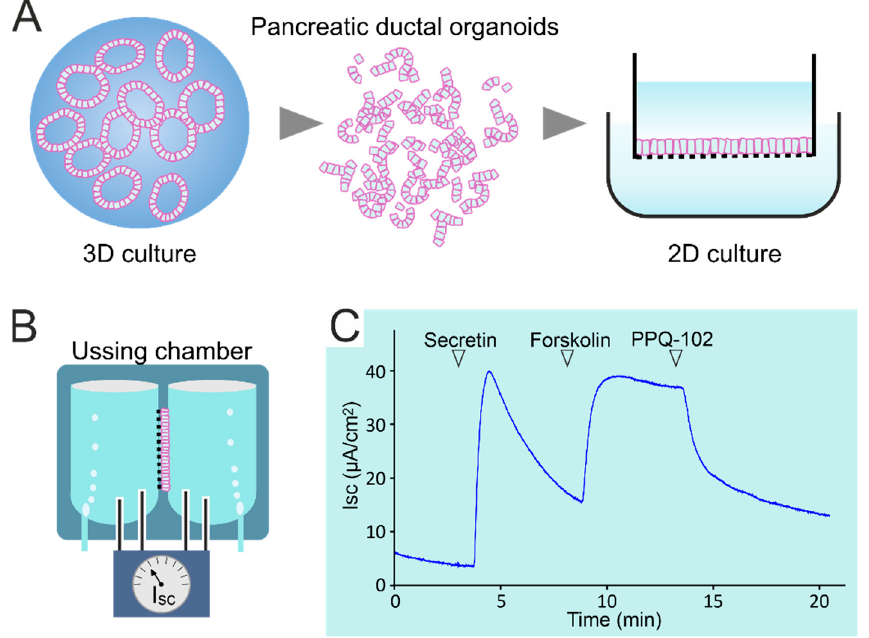
Figure 3. ( A ) Pancreatic ducts were isolated from a porcine pancreas by enzyme treatment and suspended in an extracellular matrix. From these ductal structures, spherical organoids are formed within a few days. Cultures are renewed and expanded by mechanical disruption and reseeding of the resulting cell clusters. These can also be used to initiate epithelial monolayers (2D cultures). ( B ) When cultured on a permeable substrate, monolayers can be used to assess epithelial anion transport in an Ussing chamber, analogous to ICM. ( C ) Current (Isc) response of a pancreatic organoid-derived monolayer upon stimulation by secretin and the cAMP agonist forskolin, and the effect of the CFTR blocker